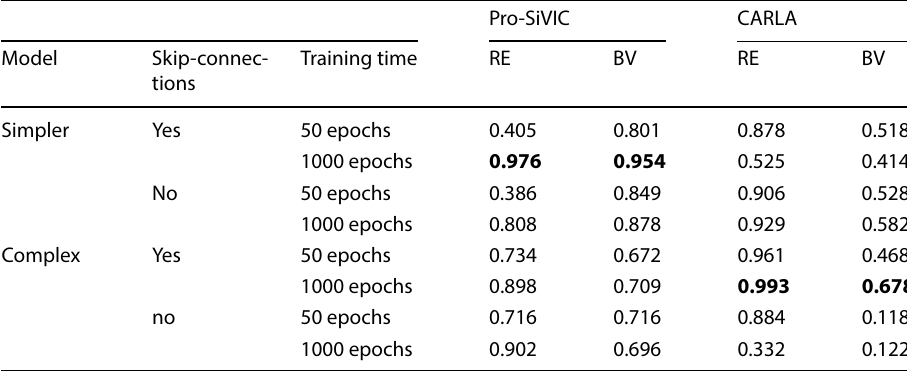
RE the reconstruction error approach, BV the bottleneck-values